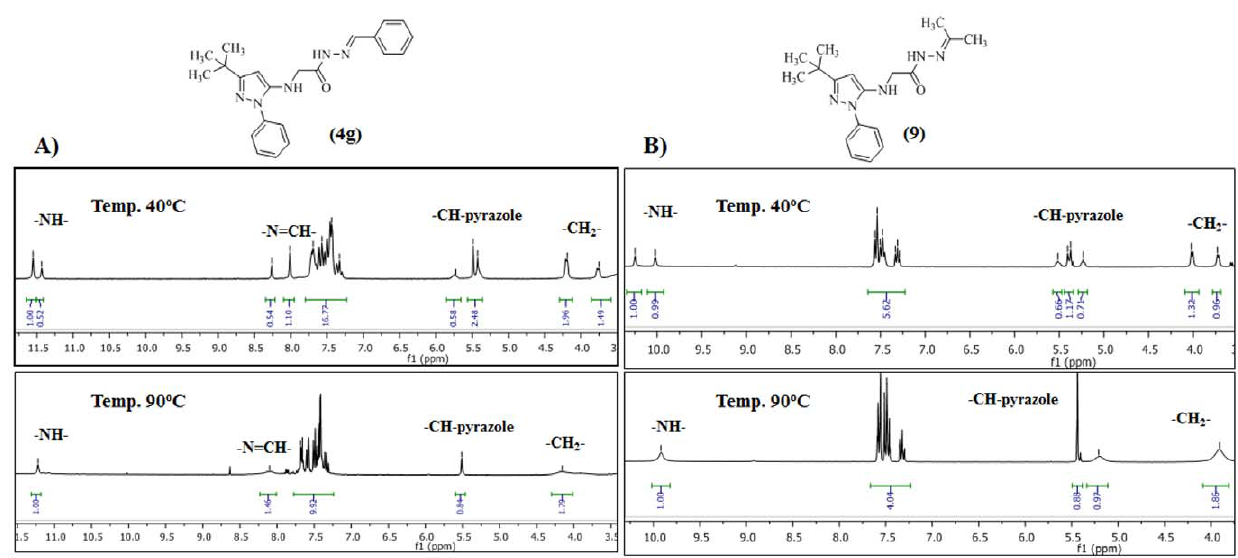
Figure 4. 1 H-NMR spectra of NAH derivatives 4g (A) and 9 (B) in DMSO-d 6 at 40 6 C and 90 6 C.